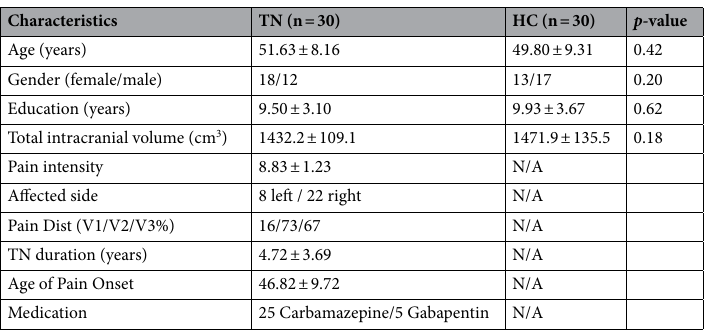
Table 1. Demographic and clinical characteristics of the trigeminal neuralgia (TN) patients and healthy controls